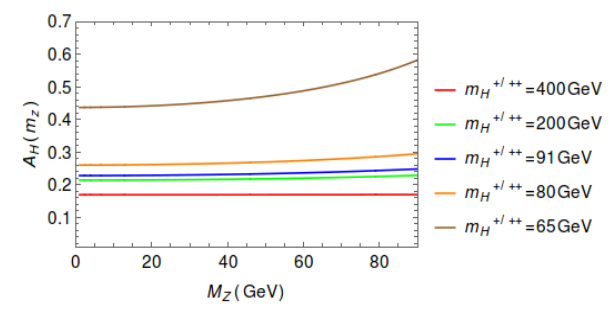
Figure 6 . Dependence of the additional scalar loop integral on the Z boson mass in h ! Z(cid:13)